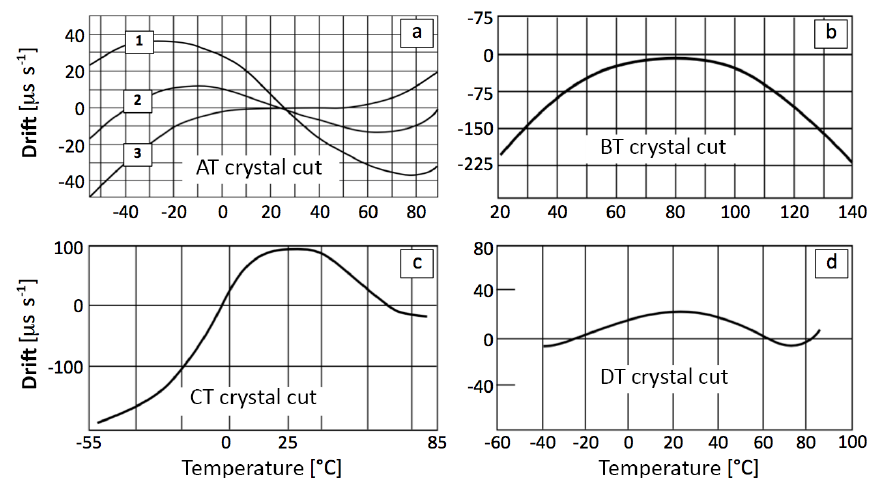
Figure 2. Exemplary temperature dependence curves for clocks with AT (a) , BT (b) , CT (c) , and DT (d) cuts. In (a) the three curves refer to different angles of rotations of the crystal. Reproduced and adjusted from Hewlett Packard